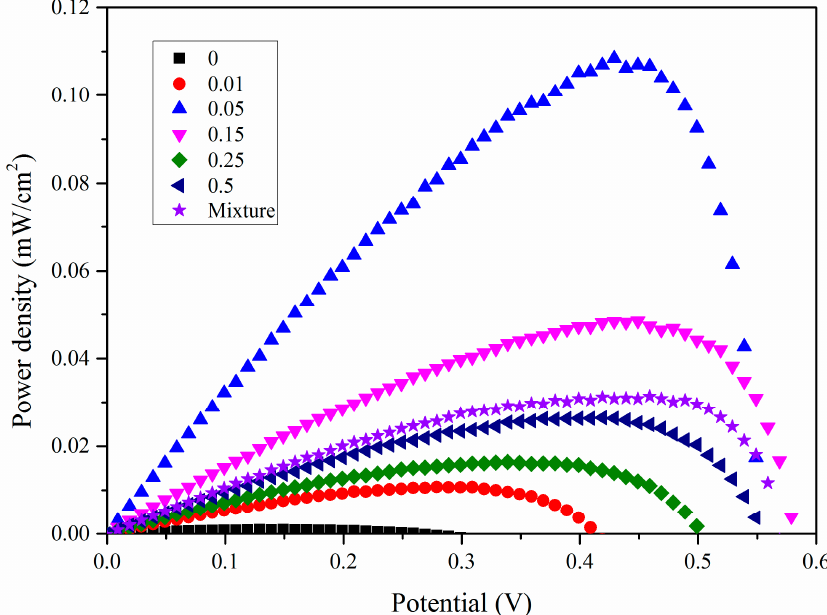
Figure 9. PV curves of a series of Bi 2 O 3 sensitized TiO 2 -based solar cells, as well as a simple mixture of Bi 2 O 3 and TiO 2 -based solar cell.